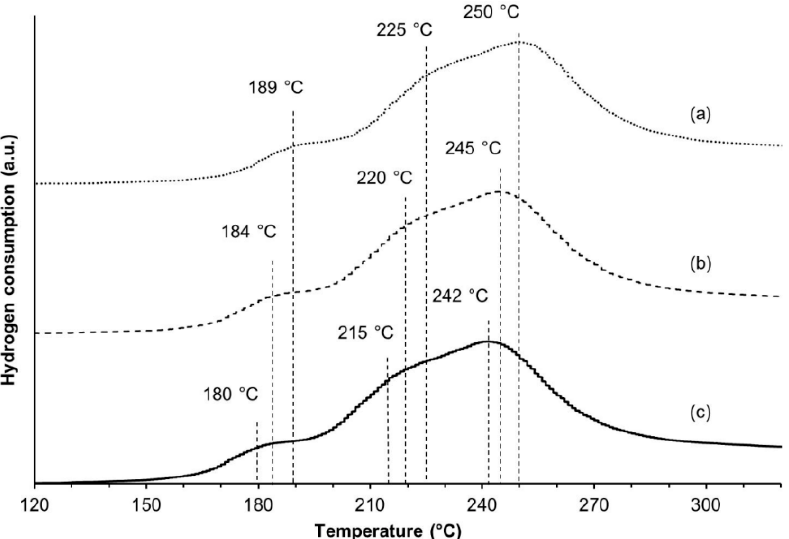
Figure 2. Temperature-programmed reduction profiles of ( a ) Cu-Zn (no magnet)/CeO 2 -Al 2 O 3 (no magnet), ( b ) Cu-Zn (N-N)/CeO 2 -Al 2 O 3 (no magnet), and ( c ) Cu-Zn (N-S)/CeO 2 -Al 2 O 3 (no magnet).